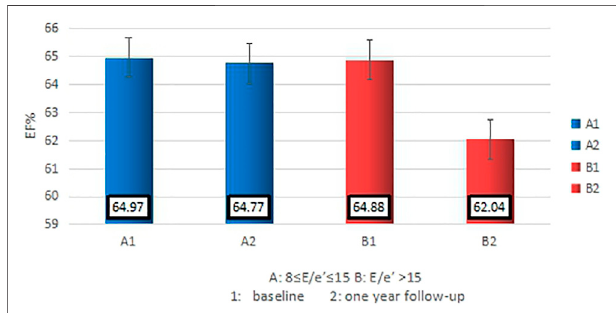
FIGURE 1 | The basiline and the 1 year follow-up LVEF of